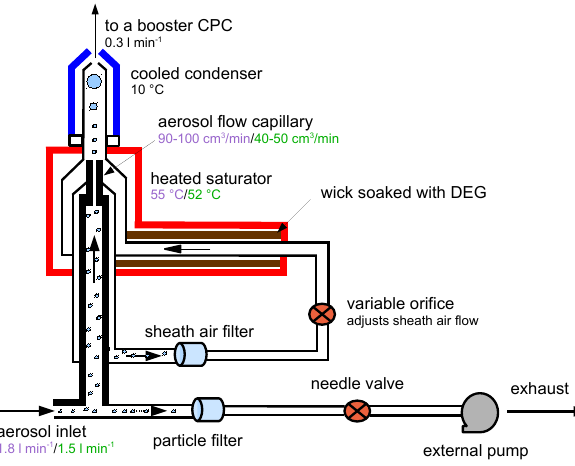
Fig. 1. A detailed overview of the setup for DEG CPC 1 and 2. The setup is based on the commercially available TSI 3776. For the DEG CPC 2 a valve and a pump were added to give the possibility to increase the inlet flow. The flow and temperature settings for each CPC are shown in magenta for the DEG CPC 2 and in green the DEG CPC